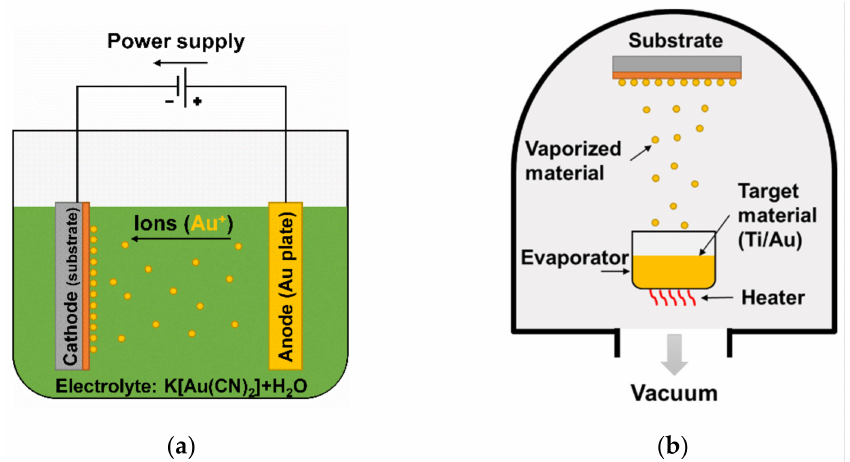
Figure 2. Schematic diagrams of two metallization methods used in the present work: ( a ) wet technology (Au electrodeposition) and ( b ) dry technology (Ti–Au vacuum